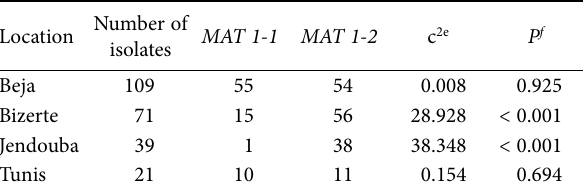
Table 3. Isolates of Ascochyta fabae collected from different loca- tions of Tunisia in the 2012 cropping season, and their mating types (MAT 1-1 and MAT 1-2) as determined by